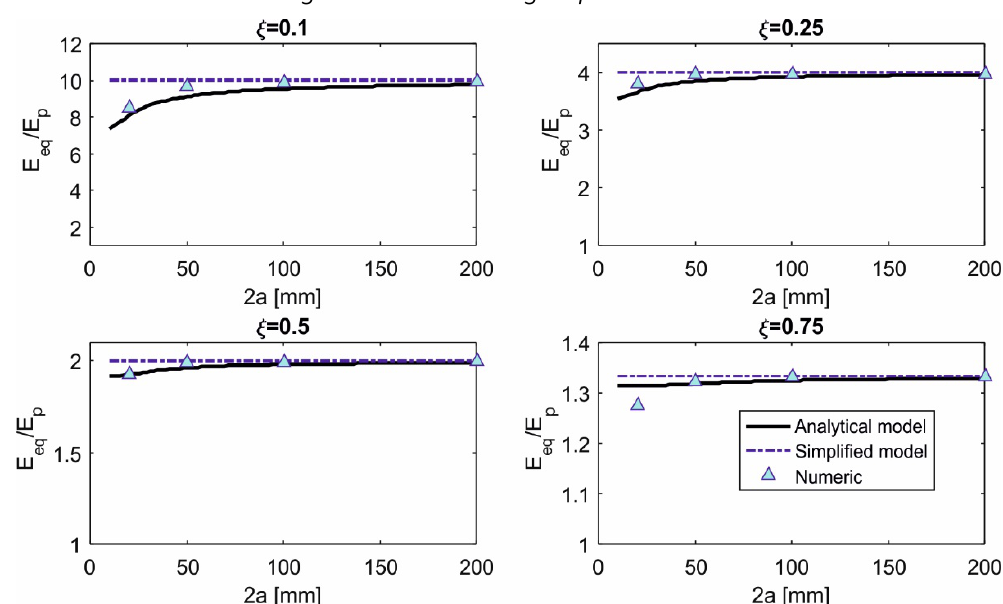
Fig. 4 Ratio E eq / E p , as a function of the fragment length 2 a , for interlayer thickness of 1.52 mm, for different values of ξ = λ / a . Comparison between analytical and numerical results.